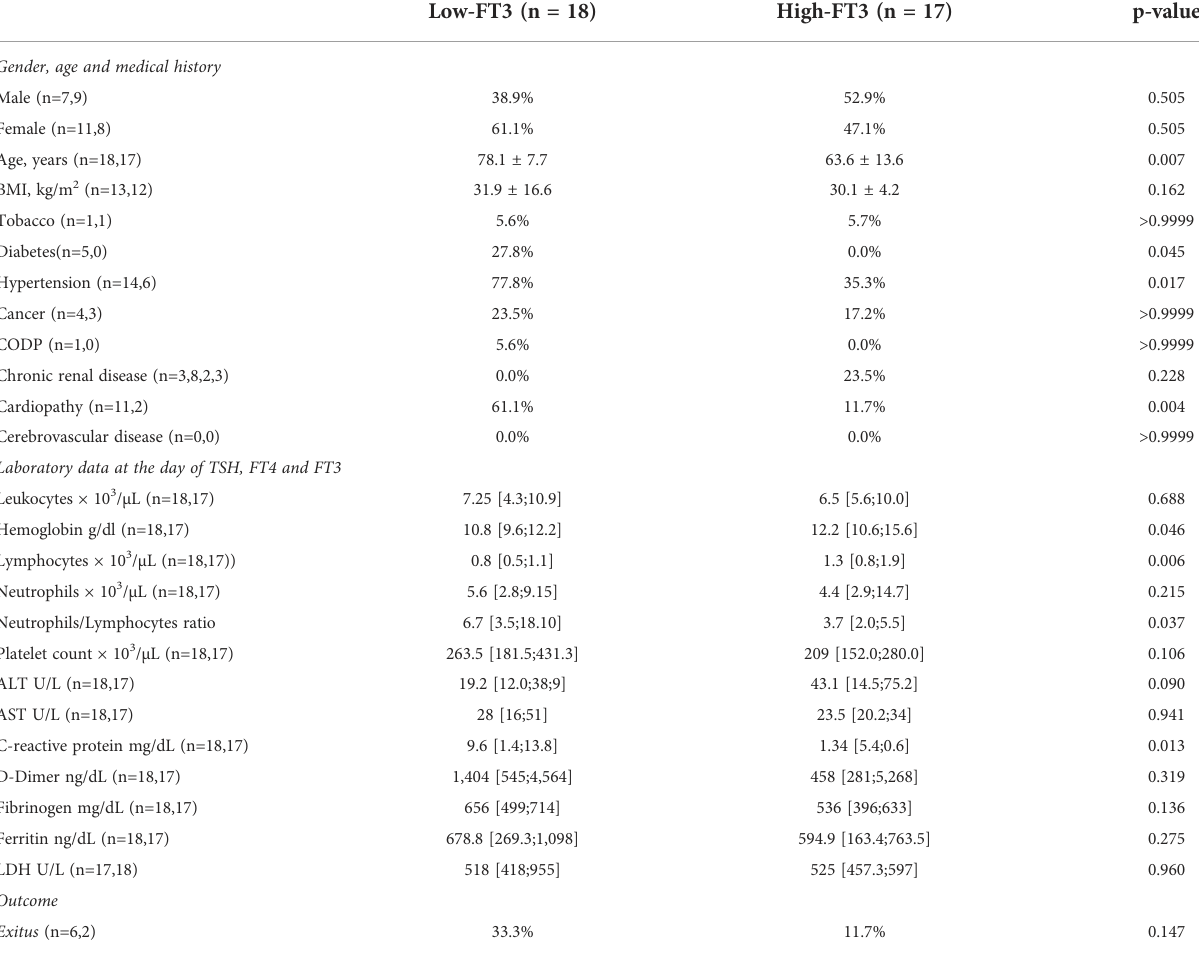
TABLE 5 Baseline characteristics, laboratory data and outcome in ward hospitalized COVID-19